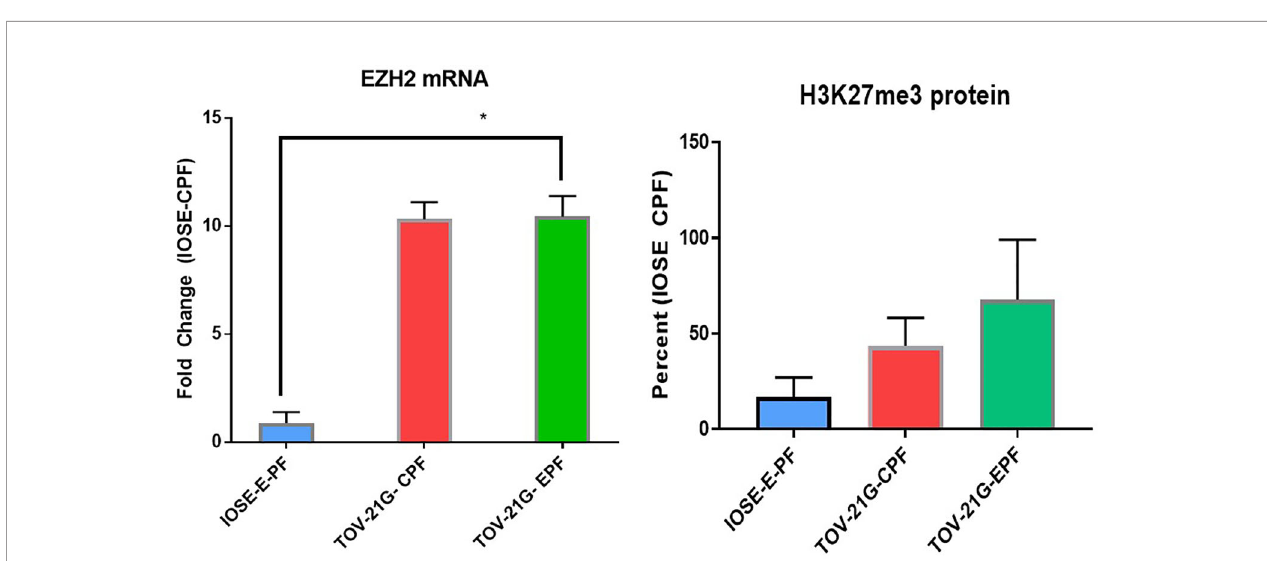
FIGURE 2 | Peritoneal fl uid modulates the expression of EZH2/H3k27me3 in IOSE and TOV-21G cells. *p < 0.05.